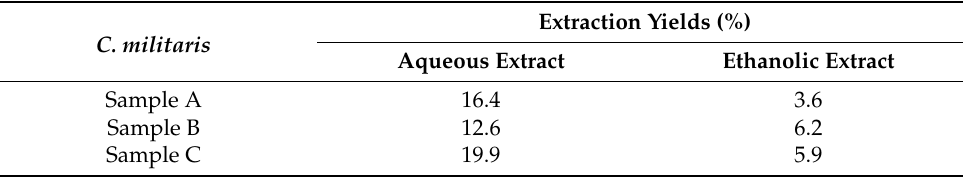
Table 2. Percentage yield of C. militaris crude extracts from different